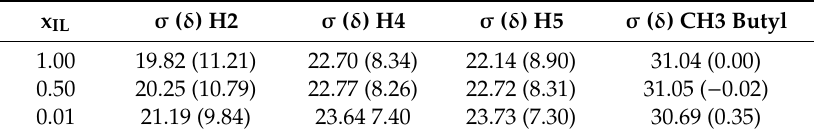
Table 2. Calculated average isotropic absolute shielding constants, σ , and corresponding chemical shifts, δ , in parenthesis calculated with respect to the butyl CH 3 resonance, in ppm. Error on the mean, after considering 100 configurations, is ± 0.1 ppm.